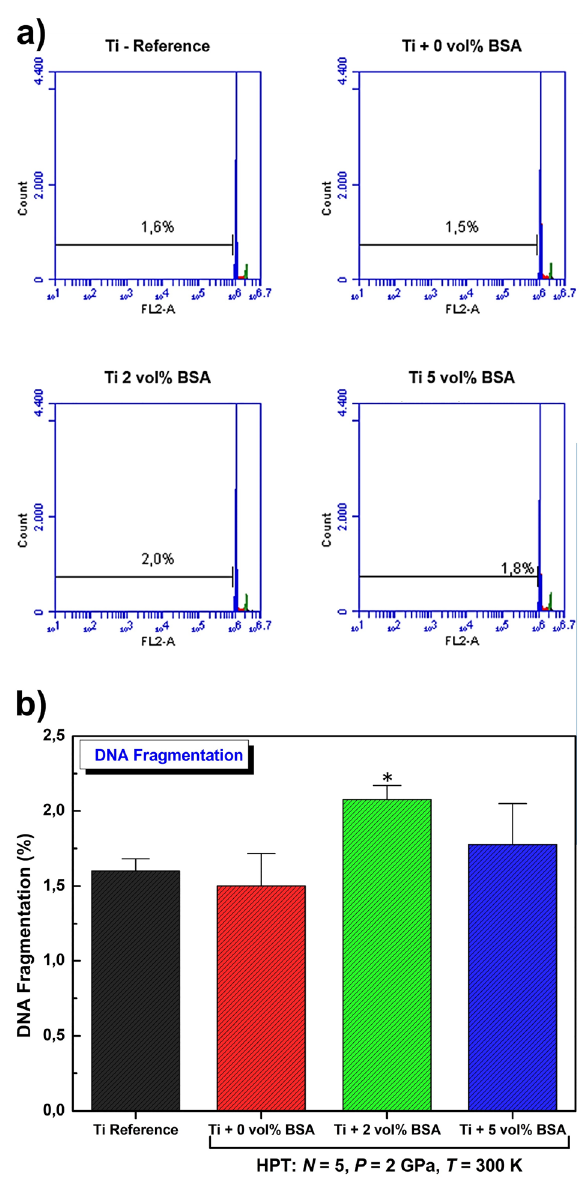
Figure 7. DNA fragmentation of MC3T3-E1 cells. ( a ) Representative histograms of percentage of cell fragmentation. ( b ) The number of cells with fragmented DNA is shown as the percentage. Data are